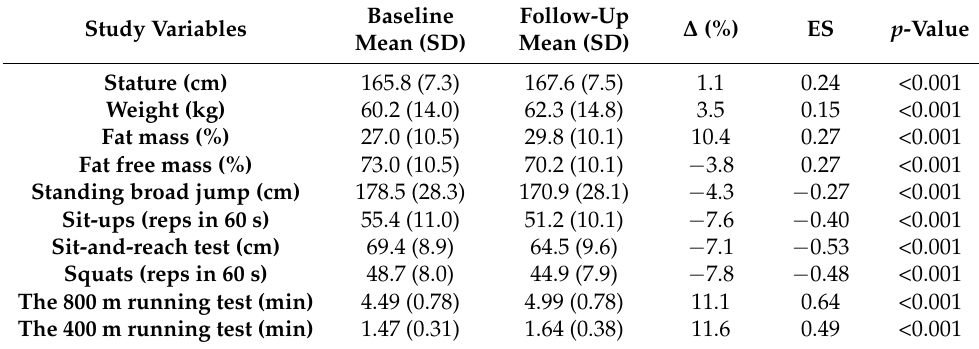
Table 1. Descriptive statistics of the study participants at the baseline and follow-up (N = 240).